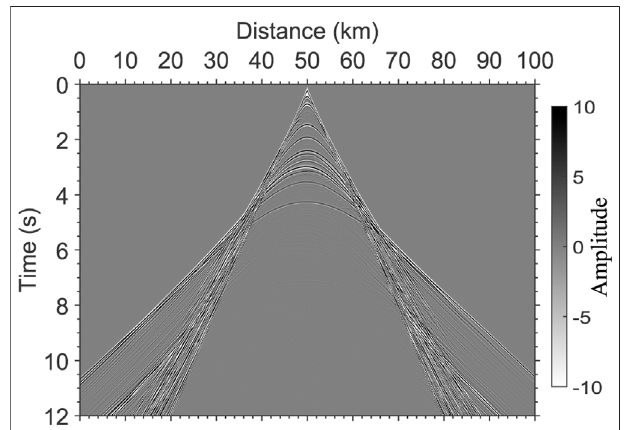
FIGURE 7 | One shot record acquired in the middle of the model. The maximum offset is 50 km.